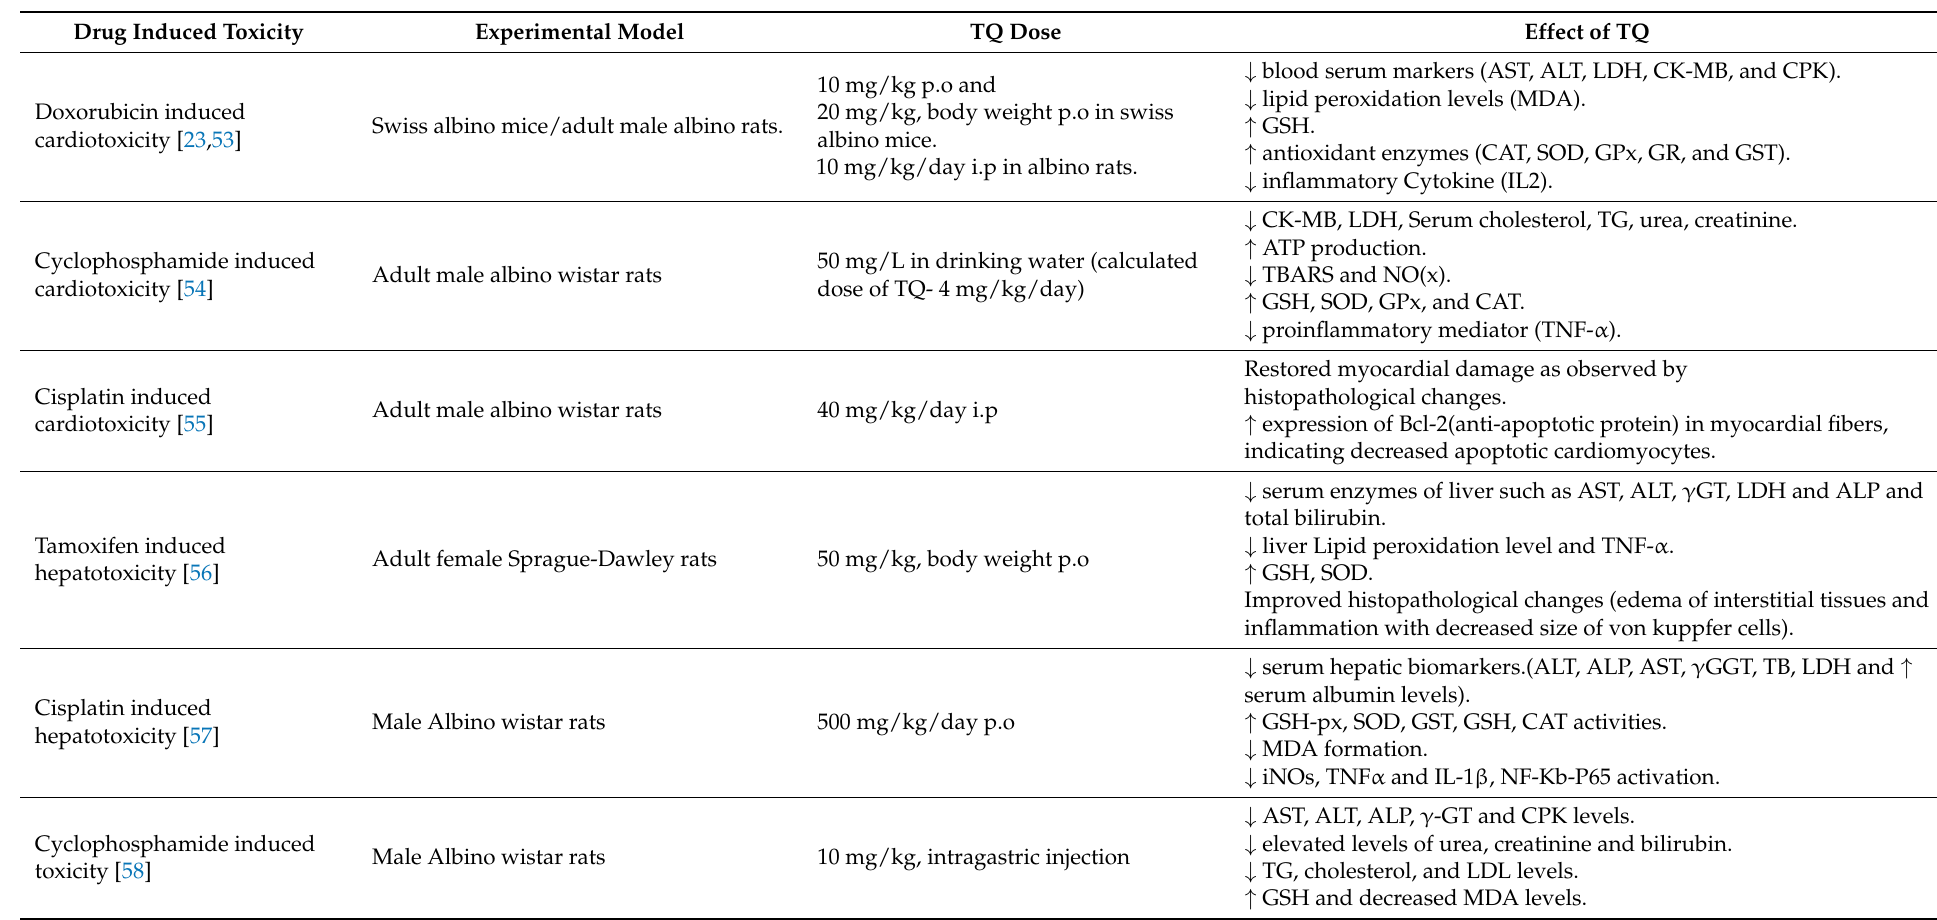
Table 2. Effect of thymoquinone against chemotherapy-induced